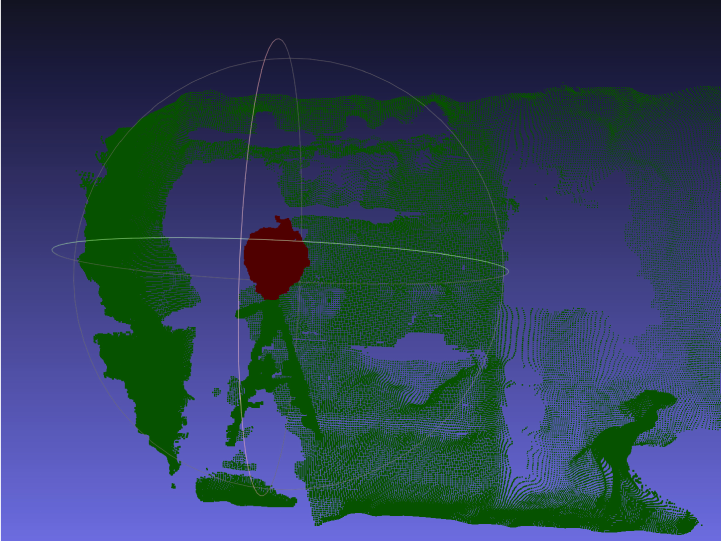
Figure 12. Scene of the second 3D point cloud experiment, the correct detection of the basketball is observed, to greater clarity the points belonging to the ball are colored in